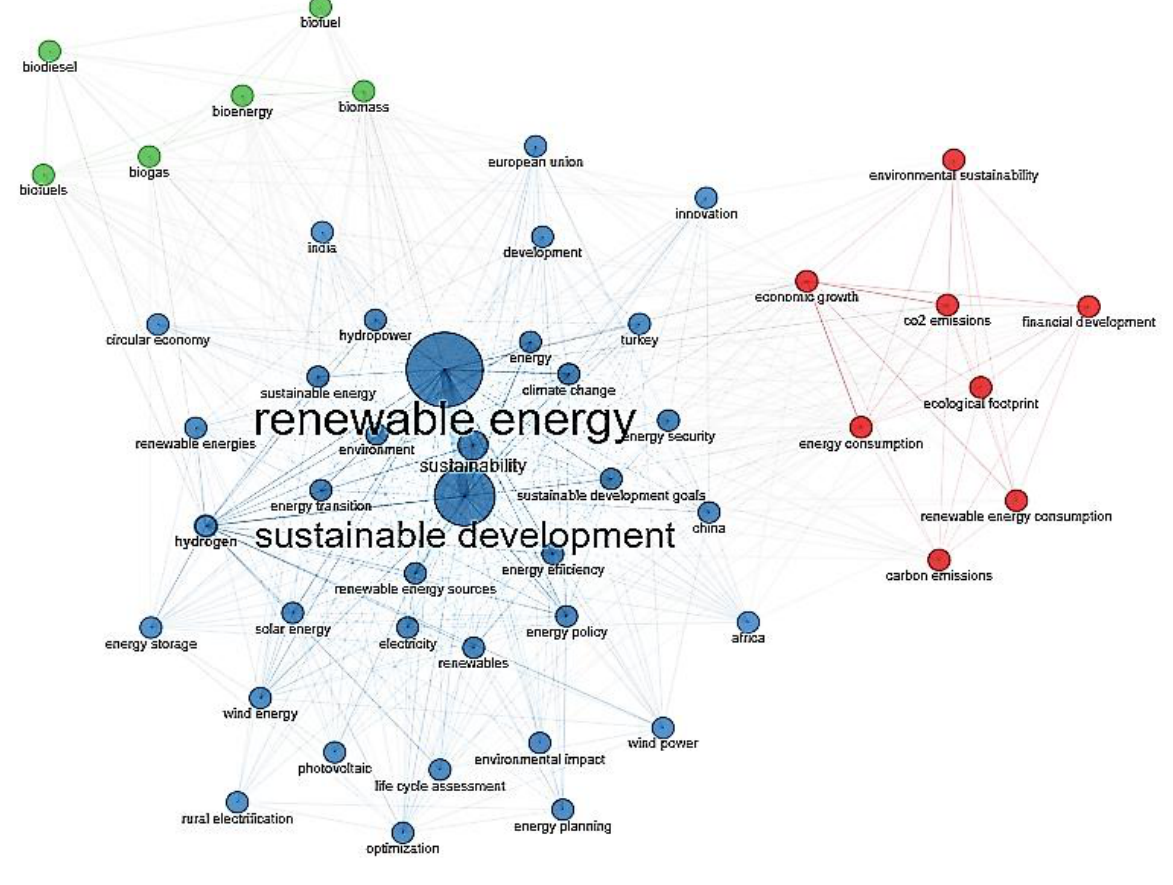
Figure 6. Co-occurrence network of keywords .